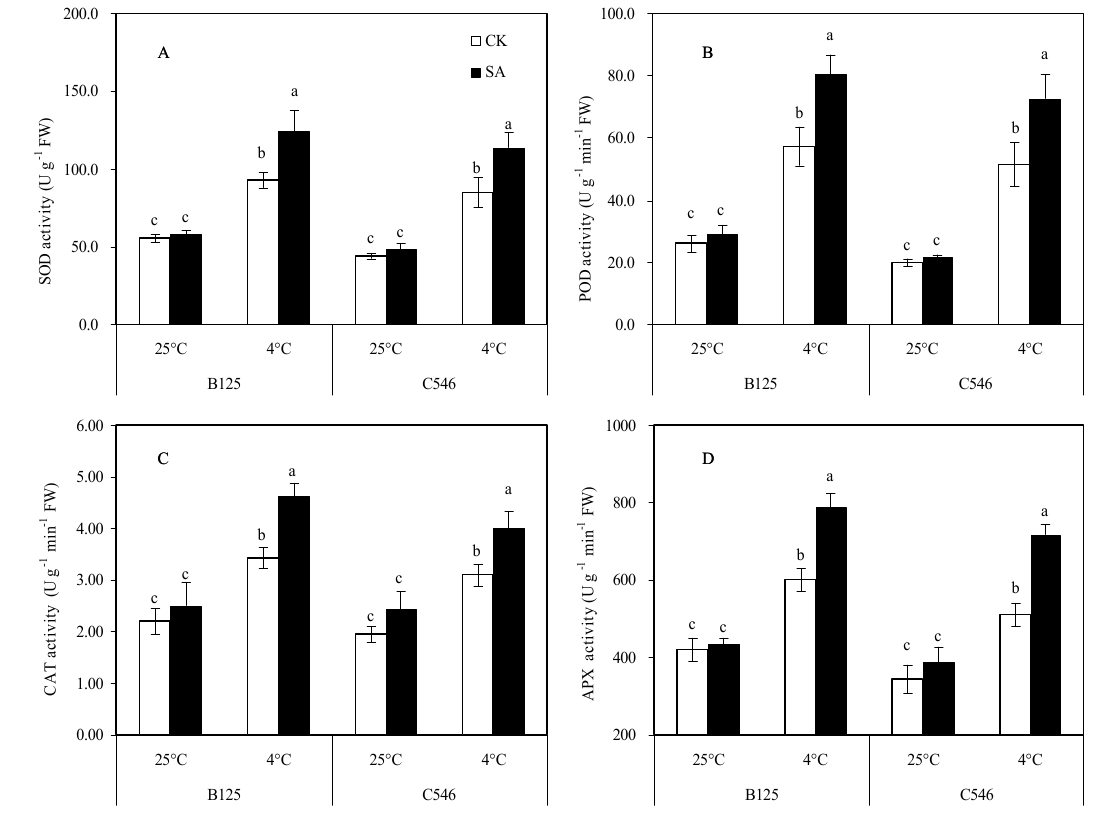
Figure 5. Effects of SA treatment on antioxidative enzyme activities in C546 and B125 maize seedlings. ( A ) SOD activity, ( B ) POD activity, ( C ) CAT activity, and ( D ) APX activity. The plants were treated at 4 °C for 2 days. The different letters indicate significant differences between different SA concentrations under two temperatures within the same inbred line at p < 0.05.